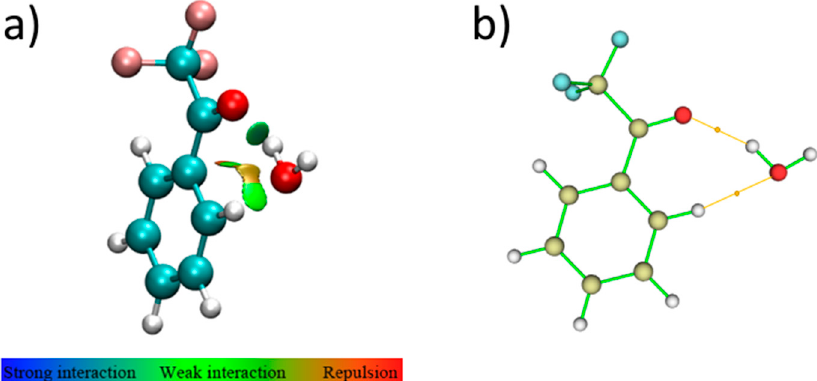
Figure 4. ( a ) Noncovalent interactions stabilizing the isomer I of TFAP-W. ( b ) QTAIM analysis of isomer I . The bond critical points (i.e., the saddle points of electron density between two atoms) are identified by orange dots and the bond paths are represented by orange lines.